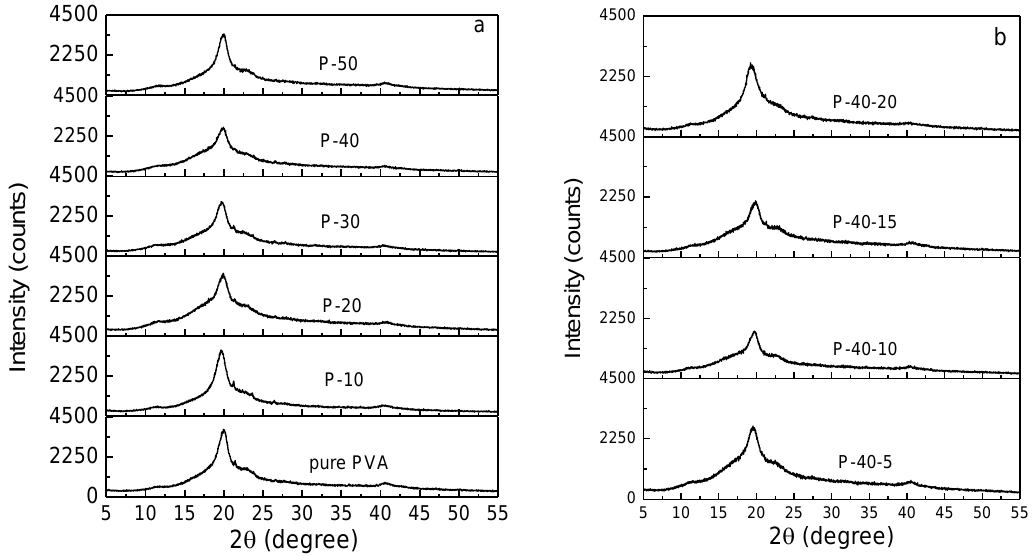
Figure 1. XRD patterns of ( a ) pure poly(vinyl alcohol) (PVA), P-10, P-20, P-30, P-40, and P-50; and ( b ) P-40-5, P-40-10, P-40-15, and P-40-20 films.